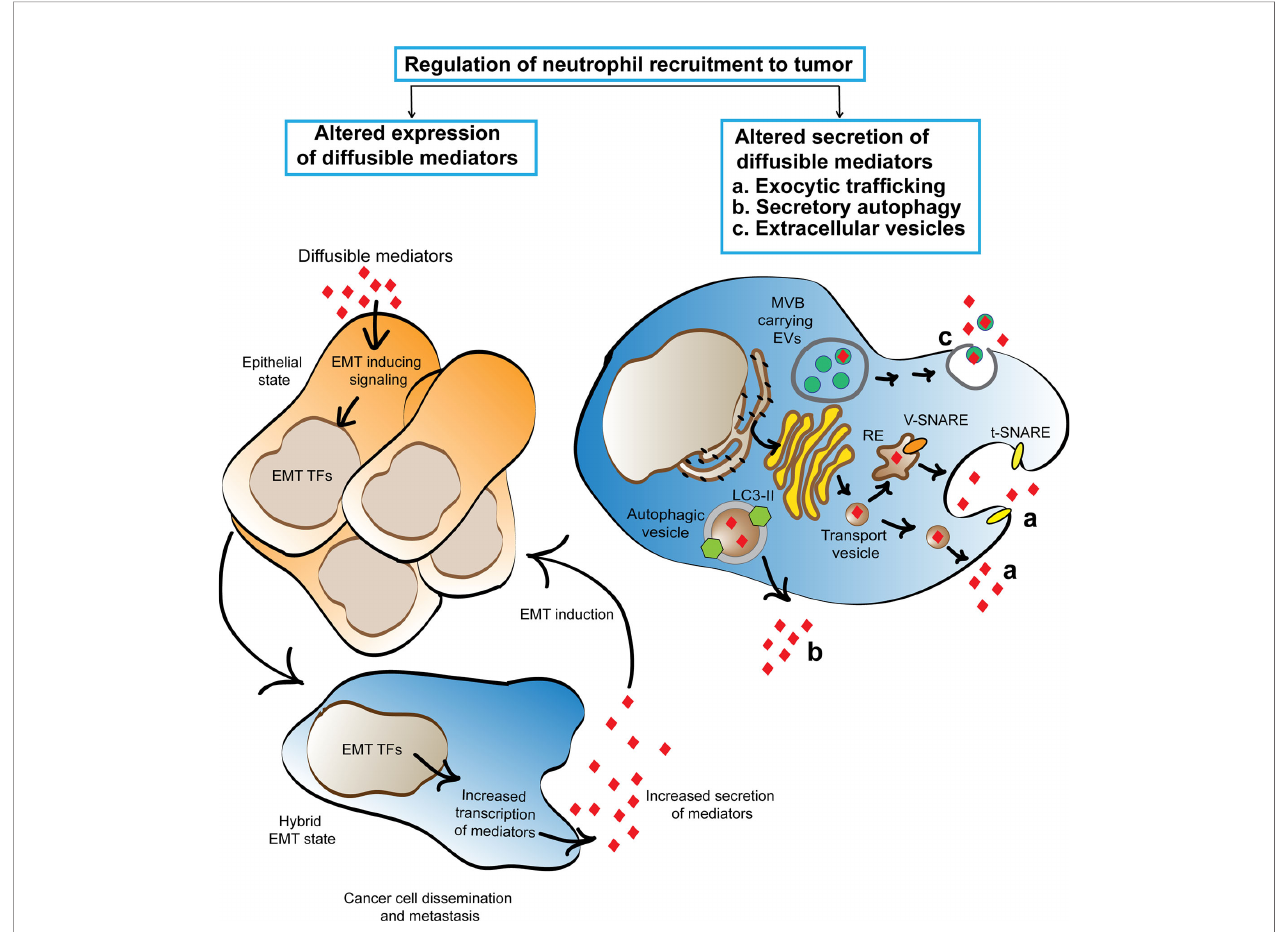
FIGURE 1 | Cartoon depicting the proposed mechanisms that regulate the cancer secretome and favor neutrophil traf fi cking to tumors. Cancer associated EMT program activation alters cancer cell secretome by inducing the expression of neutrophil recruiting mediators. Three machineries, namely exocytic traf fi cking, secretory autophagy, and extracellular vesicles are proposed to enhance the release of neutrophil recruiting mediators from cancer cells. The secreted mediators promote EMT using a feed forward mechanism and initiate a chronic cycle of in fl ammation that supports cancer cell dissemination. TFs, transcription factors; RE, recycling